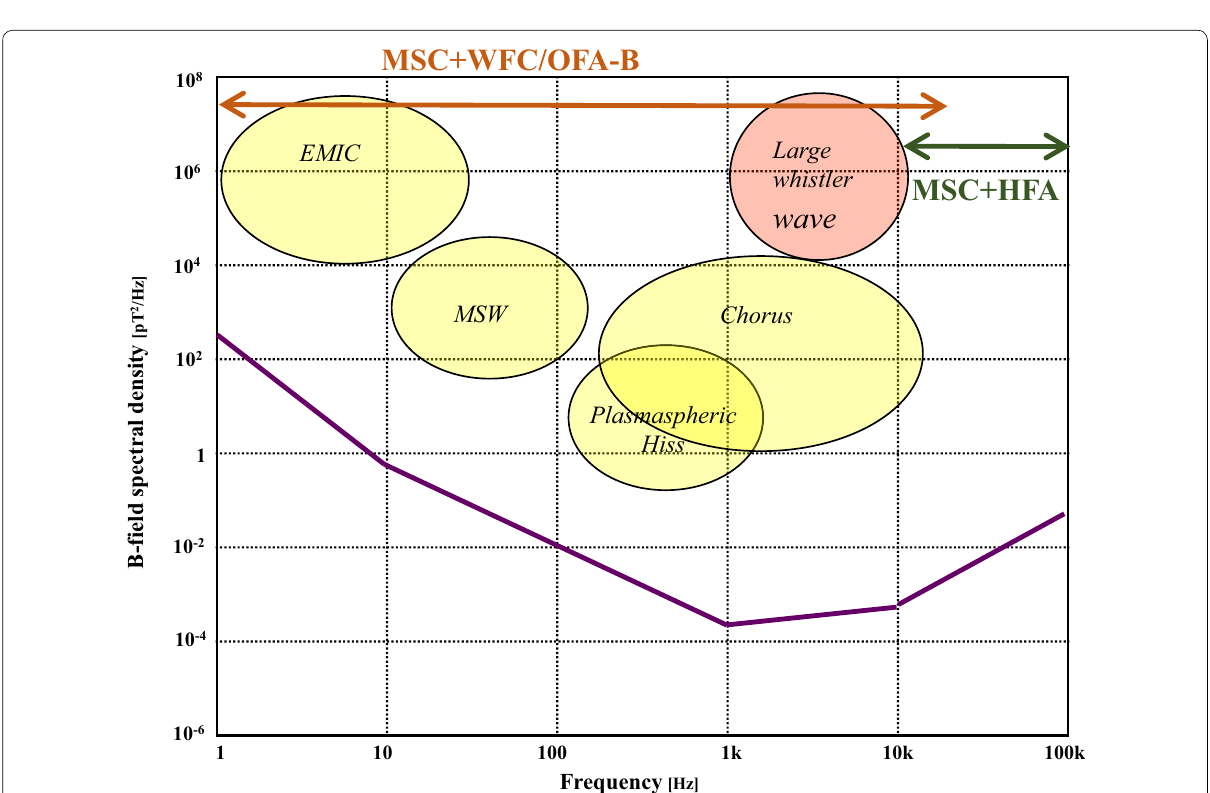
Fig. 5 Magnetic field wave phenomena as scientific targets of the ERG mission, and magnetic field sensor sensitivities and frequency coverage using the MSC and the receivers (WFC/OFA(B), and